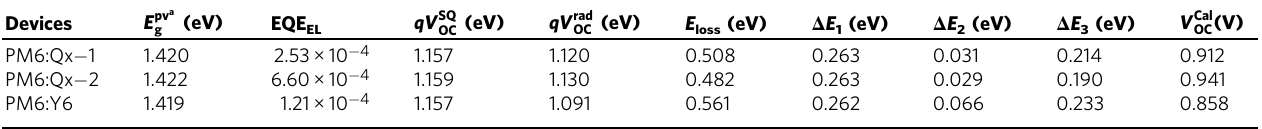
Table 2 Energy loss of the devices based on Qx-1, Qx-2 and Y6 acceptors with PM6 donor.